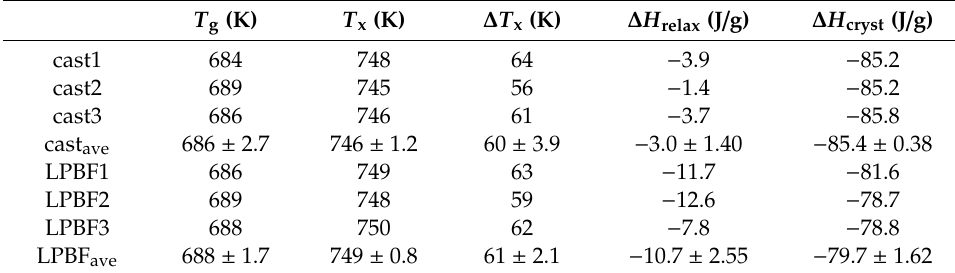
Table 1. Overview of the characteristic temperatures of Zr 52.5 Ti 5 Cu 18 Ni 14.5 Al 10 BMGs synthesized by LPBF and copper mold casting determined via DSC (heating rate 20 K / min). Glass transition ( T g ) and crystallization ( T x ) temperatures, the width of the supercooled liquid region ( ∆ T x ), relaxation enthalpies ( ∆ H relax ), and crystallization enthalpies ( ∆ H cryst ) are listed. T g